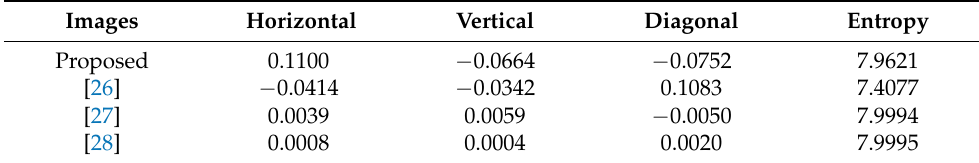
Table 4. Correlation Coefficient and entropy comparison with state-of-the-art methods. Images Horizontal Vertical